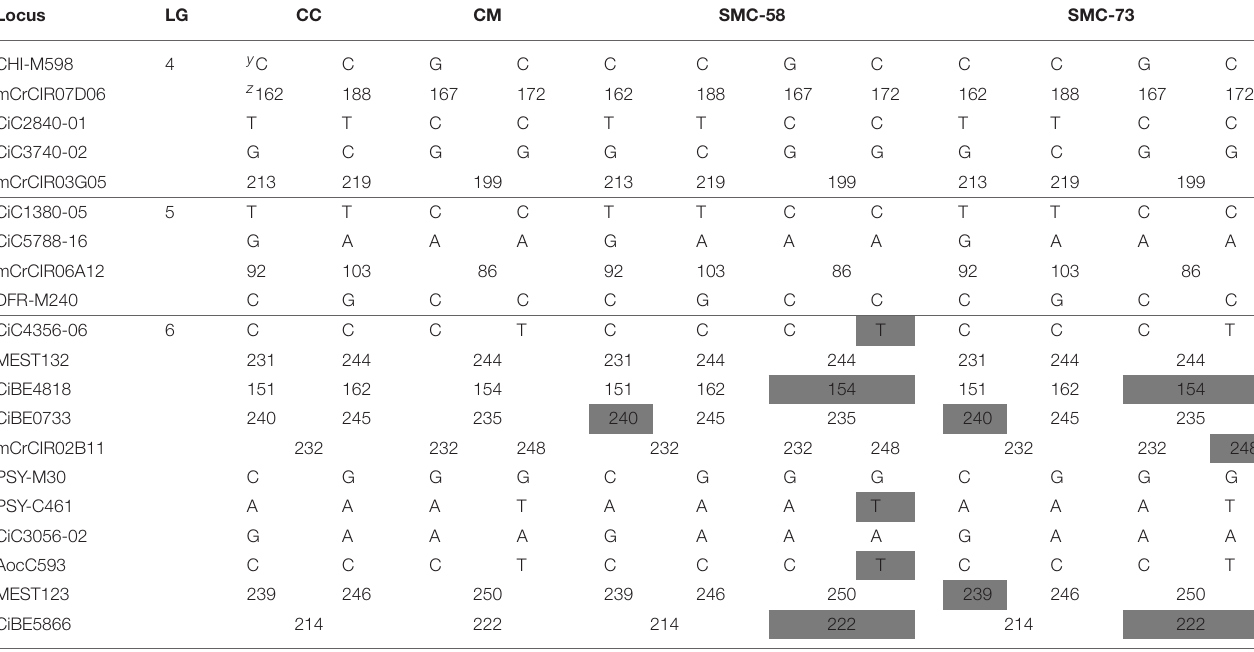
TABLE 6 | Genetic analysis using SNP and SSR nuclear markers located on LGs 4, 5, and 6 performed on SMC-58 and SMC-73 somatic hybrids that were obtained by protoplast fusion between C. macrophylla (CM) and Carrizo citrange (CC). Locus LG CC CM SMC-58 SMC-73 CHI-M598 4 y C